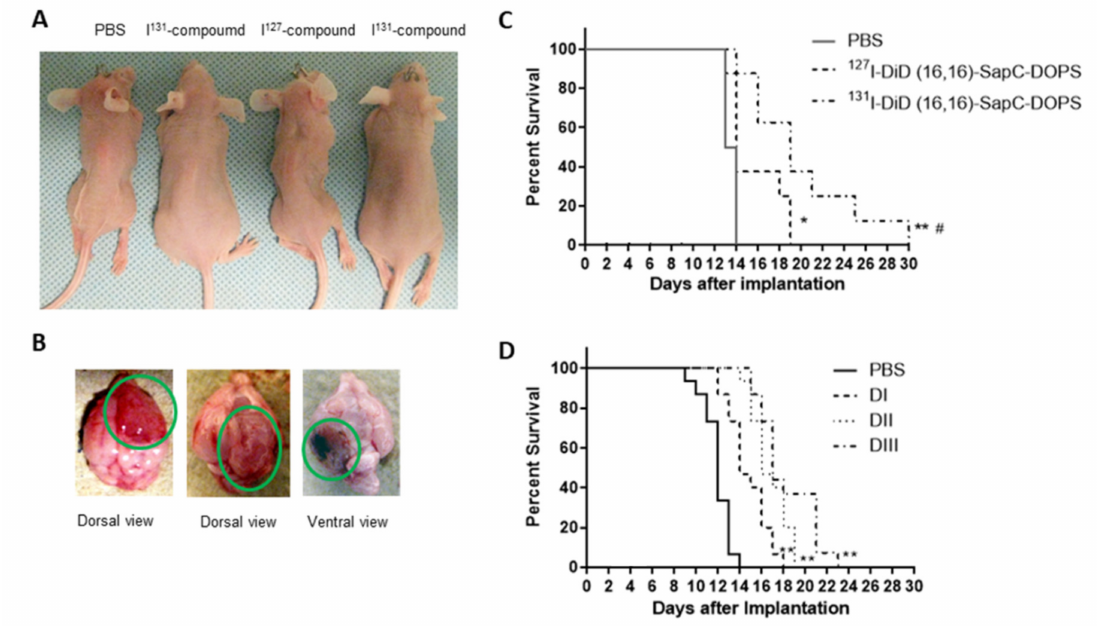
Figure 6. Physical characteristics of glioblastoma multiforme (GBM)-bearing mice after treatments. ( A ) Whole body images of live anesthetized mice 13 days after implantation of the GBM tumor cells (1 × 10 5 U87 ∆ EGFR-Luc). All of the mice had tumors. The control mice died within a day of when these pictures were taken. ( B ) Isolated brains showing GBM tumors following euthanasia of moribund mice. Tumors were similar in each group. ( C ) Mouse survival from glioblastomas after treatment. Two days after implantation of tumor cells, the mice (6 / group) began treatment with PBS, 127 I-DiD (16,16)-SapC-DOPS or 131 I-DiD (16,16)-SapC-DOPS (SapC = 4 mg / kg, DOPS = 2 mg / kg). The treatments with the 131 I doses were 61, 68, 177 and 93 µ Ci. Mice were euthanized when they became moribund. * p = 0.0327, PBS vs 127 I-DiD (16,16)-SapC-DOPS; ** p = 0.0004, PBS vs. 131 I-DiD (16,16)-SapC-DOPS; # p = 0.0378, 127 I-DiD (16,16)-SapC-DOPS vs 131 I-DiD (16,16)-SapC-DOPS by log-rank test. ( D ) Dose response of GBM tumors to SapC-DOPS. Mice (8 / group) were injected with U87 ∆ EGFR-Luc (1 × 10 5 cells / mouse) as in A–C with SapC-DOPS treatments started on day 4 and the mice were injected with SapC-DOPS 2 times a week. DI: SapC = 2.7 mg / kg, DOPS = 1.3 mg / kg; DII: SapC = 8 mg / kg, DOPS = 4 mg / kg; DIII: SapC = 24 mg / kg, DOPS = 12 mg / kg. ** p < 0.001 by log-rank test for each dose ( n = 6 for each